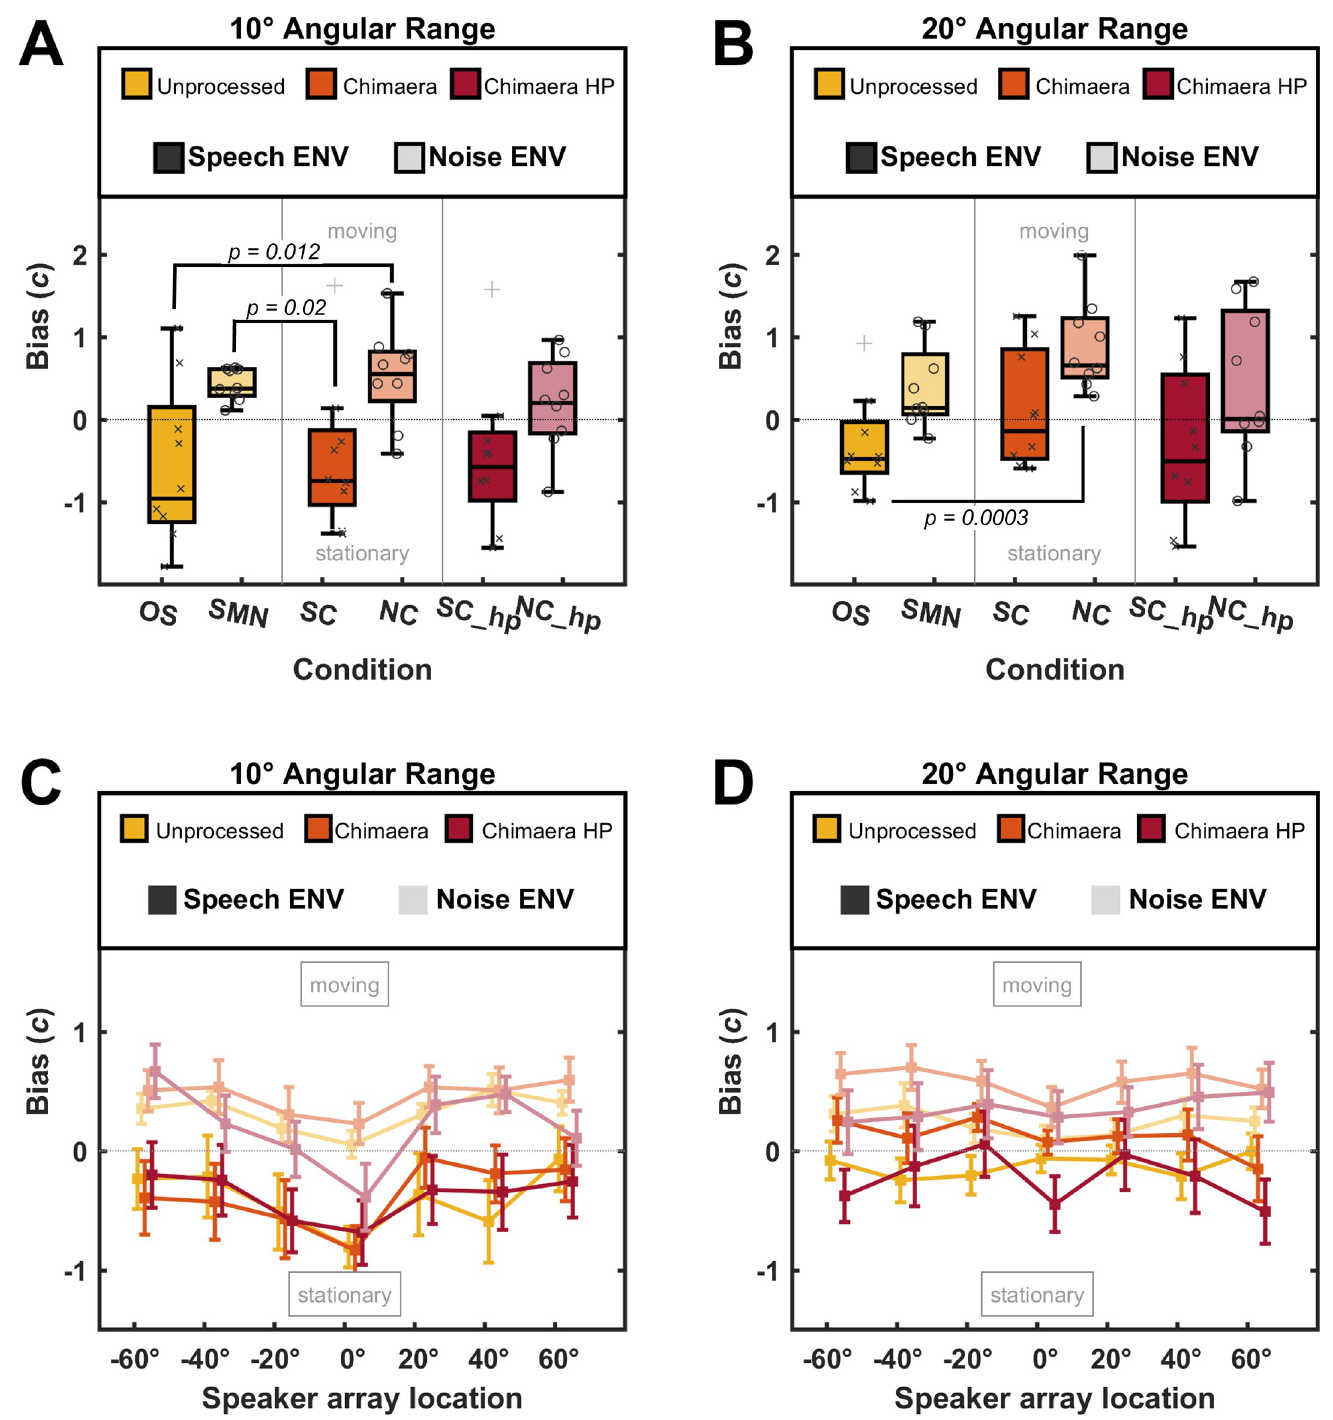
Fig 3. Bias values for Experiment I and II. (A) Bias criteria ( c , y-axis) for motion detection when sounds were stationary or moved a 10˚ angular distance across conditions (x-axis). Plotted are boxplots that mark group medians (black line) and individual data (individual markers) superimposed. Data are organized by stimulus category (color legend), and ENV type is indicated by color intensity (legend). Plus-signs denote outliers. Positive values indicate a bias to judge sounds as moving, while negative values indicate a bias to judge sounds as stationary. (B) same as (A) for motion detection when sounds were stationary or moved a 20˚ angular distance. (C) Bias criteria ( c , y-axis) from (A) as a function of sound origin location (x-axis). Mean ( ± sem) critera (square) are indicated for each category (colored legend), and ENV type is indicated by color intensity (legend). (D) same as (C) for equivalent data in (B).